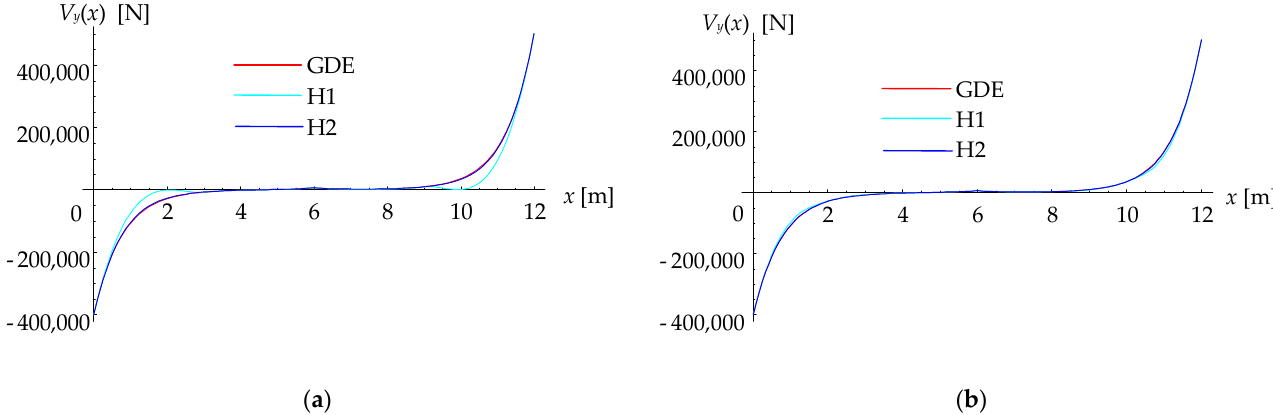
Figure 8. Comparison of shear function for four ( a ) and six ( b ) FE meshes, respectively.